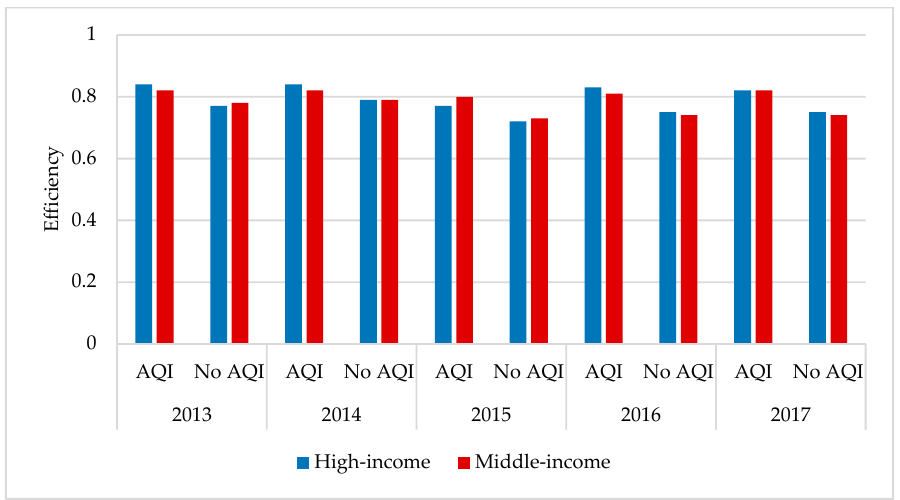
Figure 3. Total efficiency from 2013–2017 between the high- and middle-income regions. AQI: air quality index.